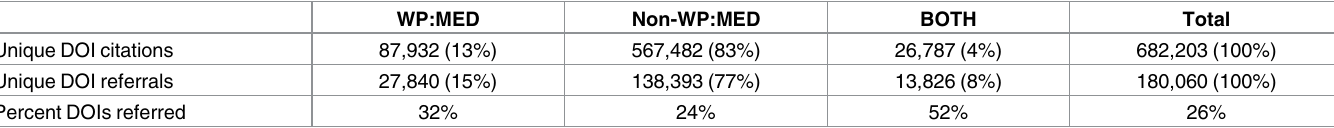
Table 7. Unique DOI citation referralsas a proportion of unique DOI citations for WP:MED alone, in non-WP:MED alone, and for BOTH during August